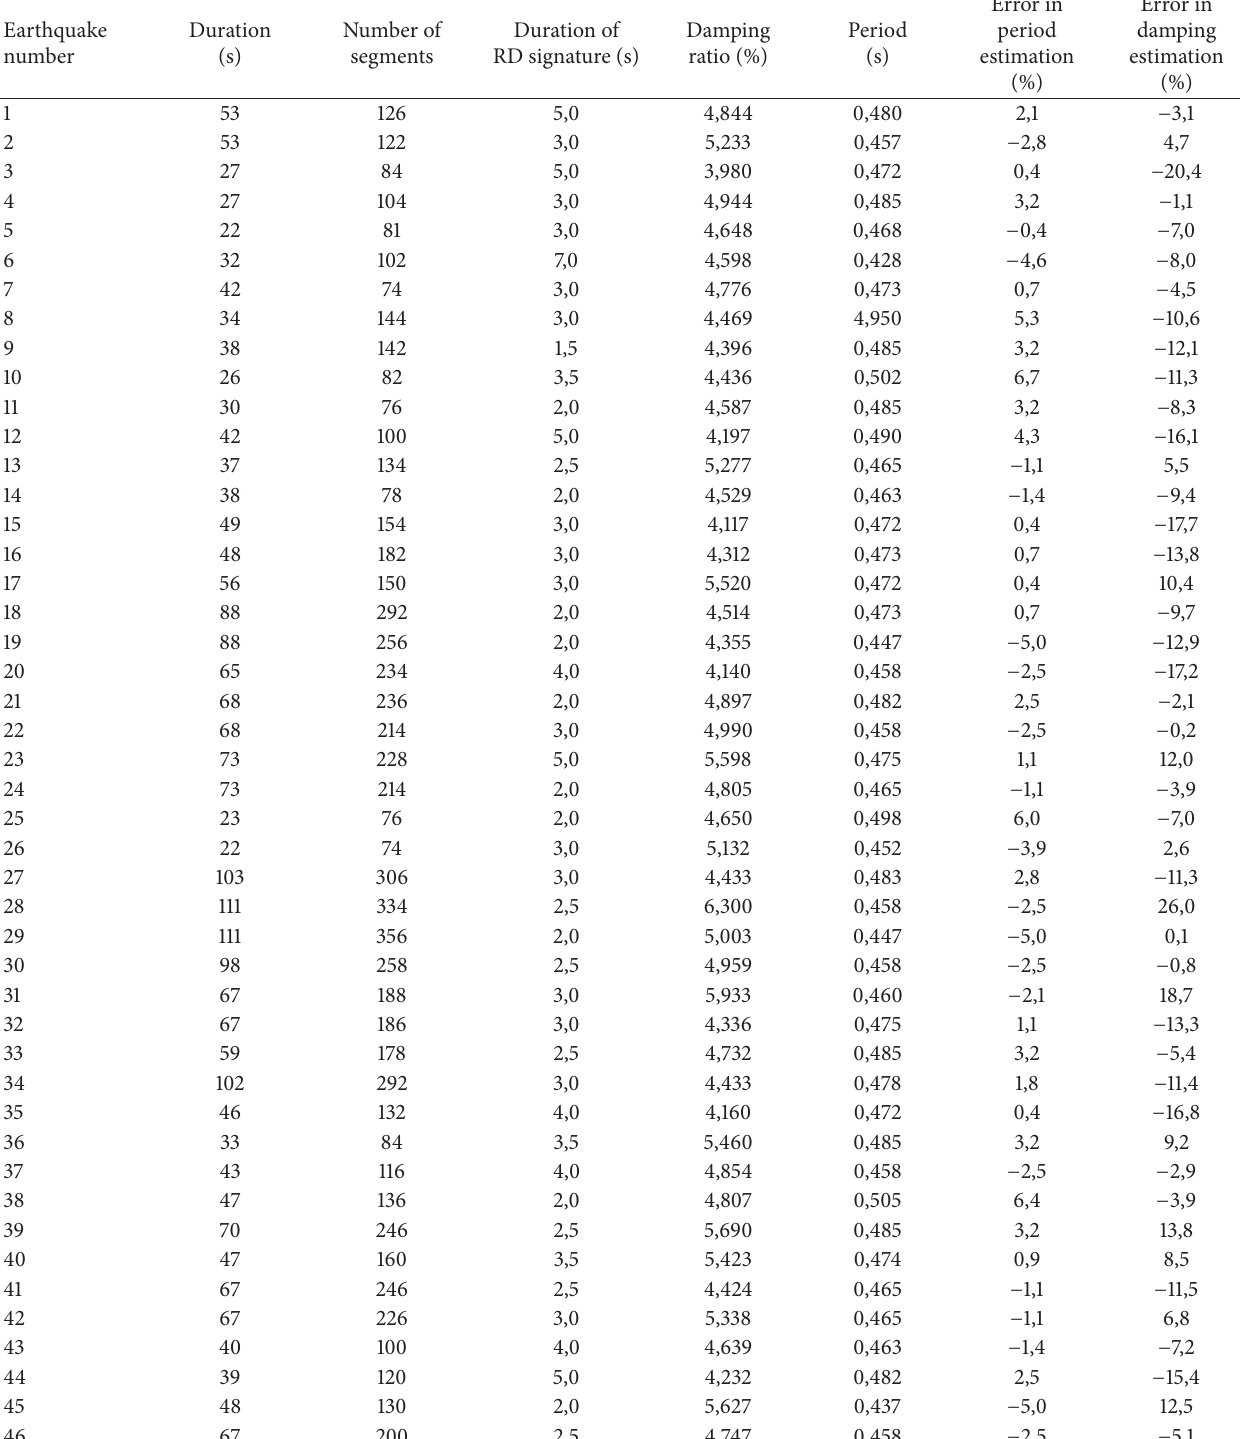
Table 1: Details of